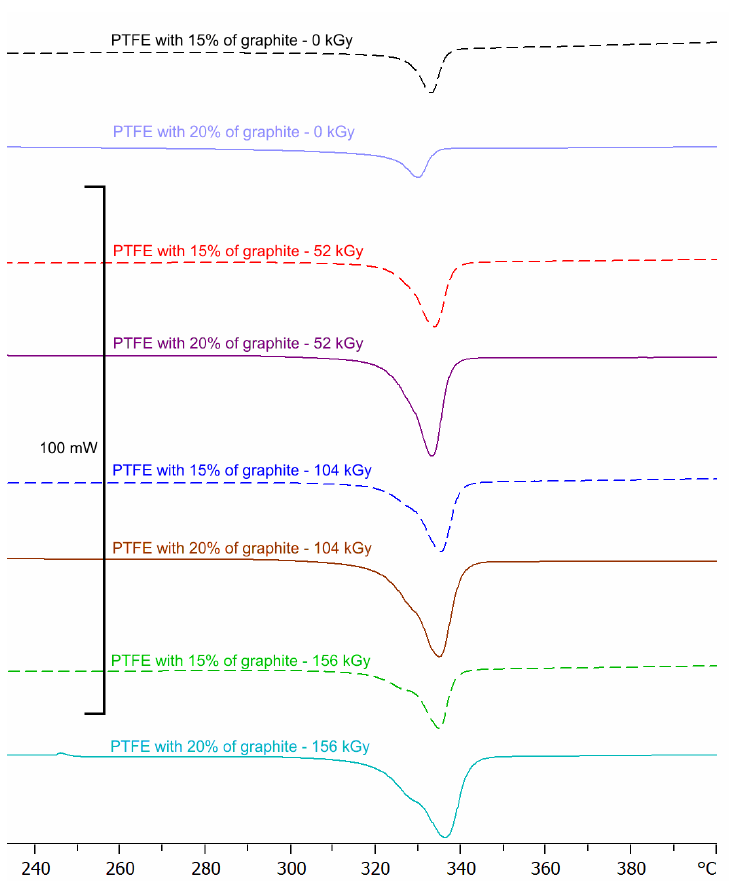
Figure 1. Differential scanning calorimetry (DSC) thermograms of polytetrafluoroethylene (PTFE) with 15% and 20% graphite addition.